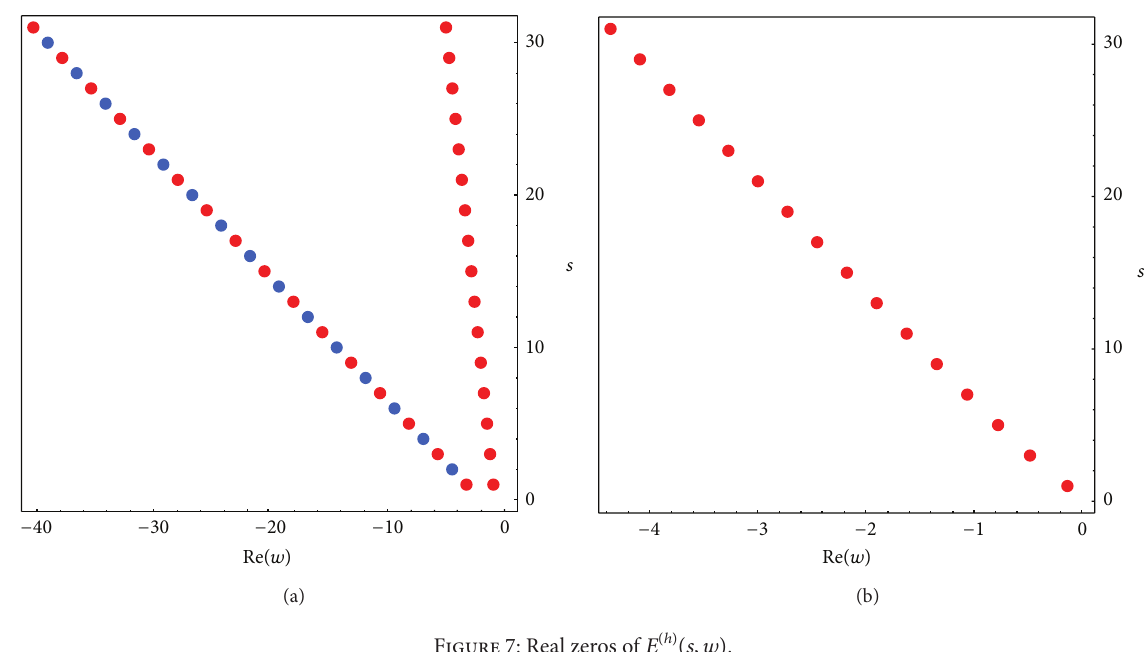
Figure 7: Real zeros of 𝐸 (ℎ) 𝑞 (𝑠,𝑤) .